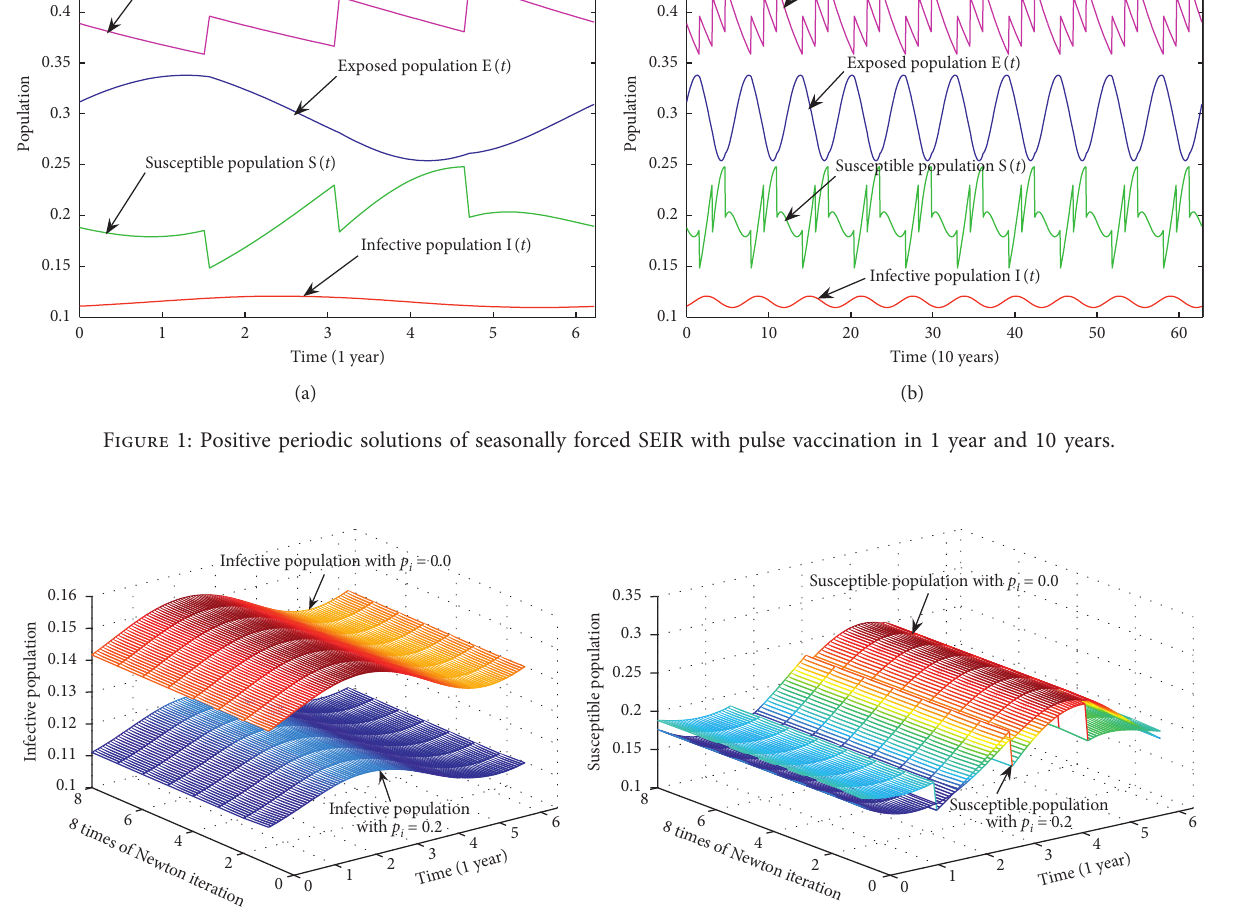
� 0 . 0 and p � 0 . 2. i i